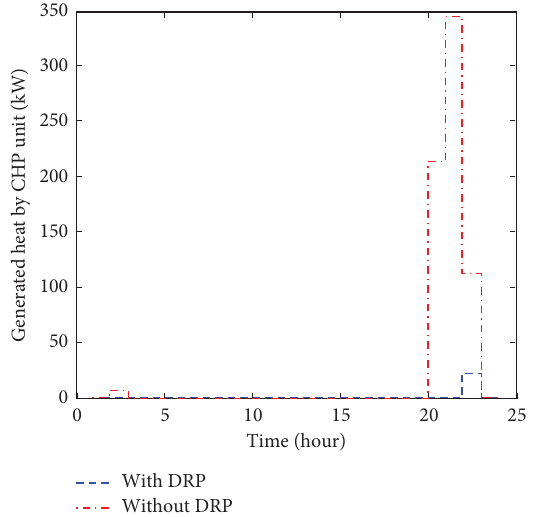
Figure 12: Generated heat by the CHP unit.